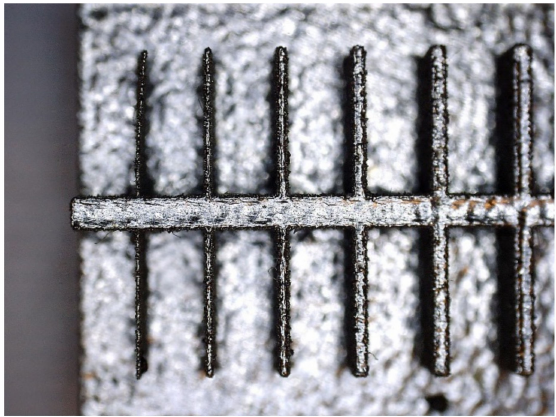
Figure 27. Presentation of the deformation of a fragment of a detail of a rectangular model made in the DMLS